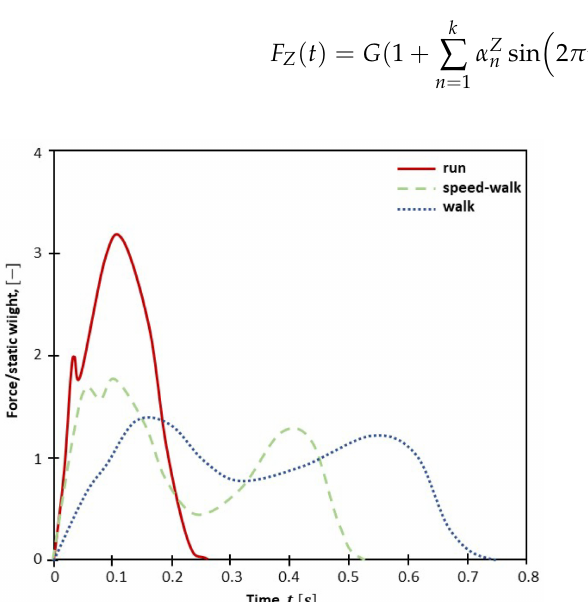
Figure 4. Normalized vertical contact force against time: run, speed-walk, and walk conditions. An elaboration of [39].